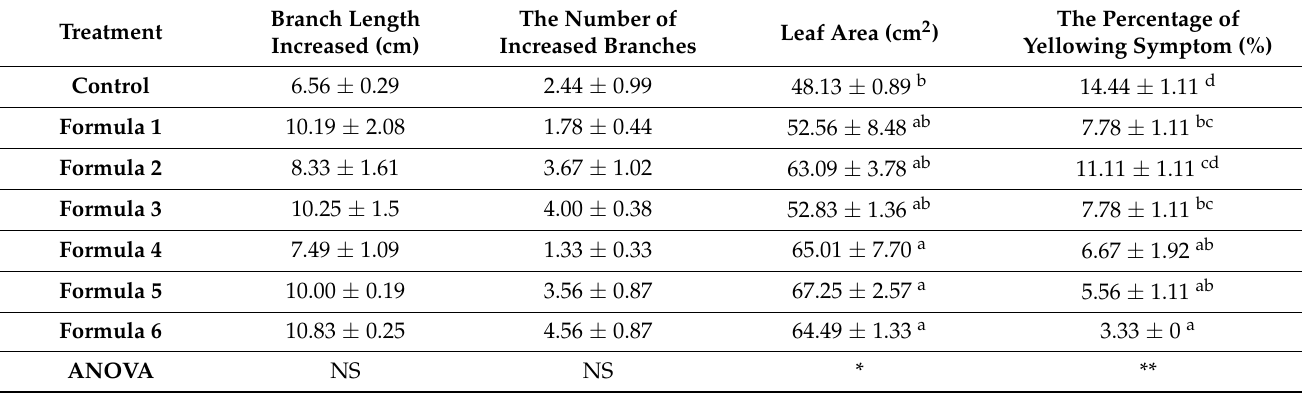
Table 7. Effects of bio-products on growth and yellowing disease of black pepper